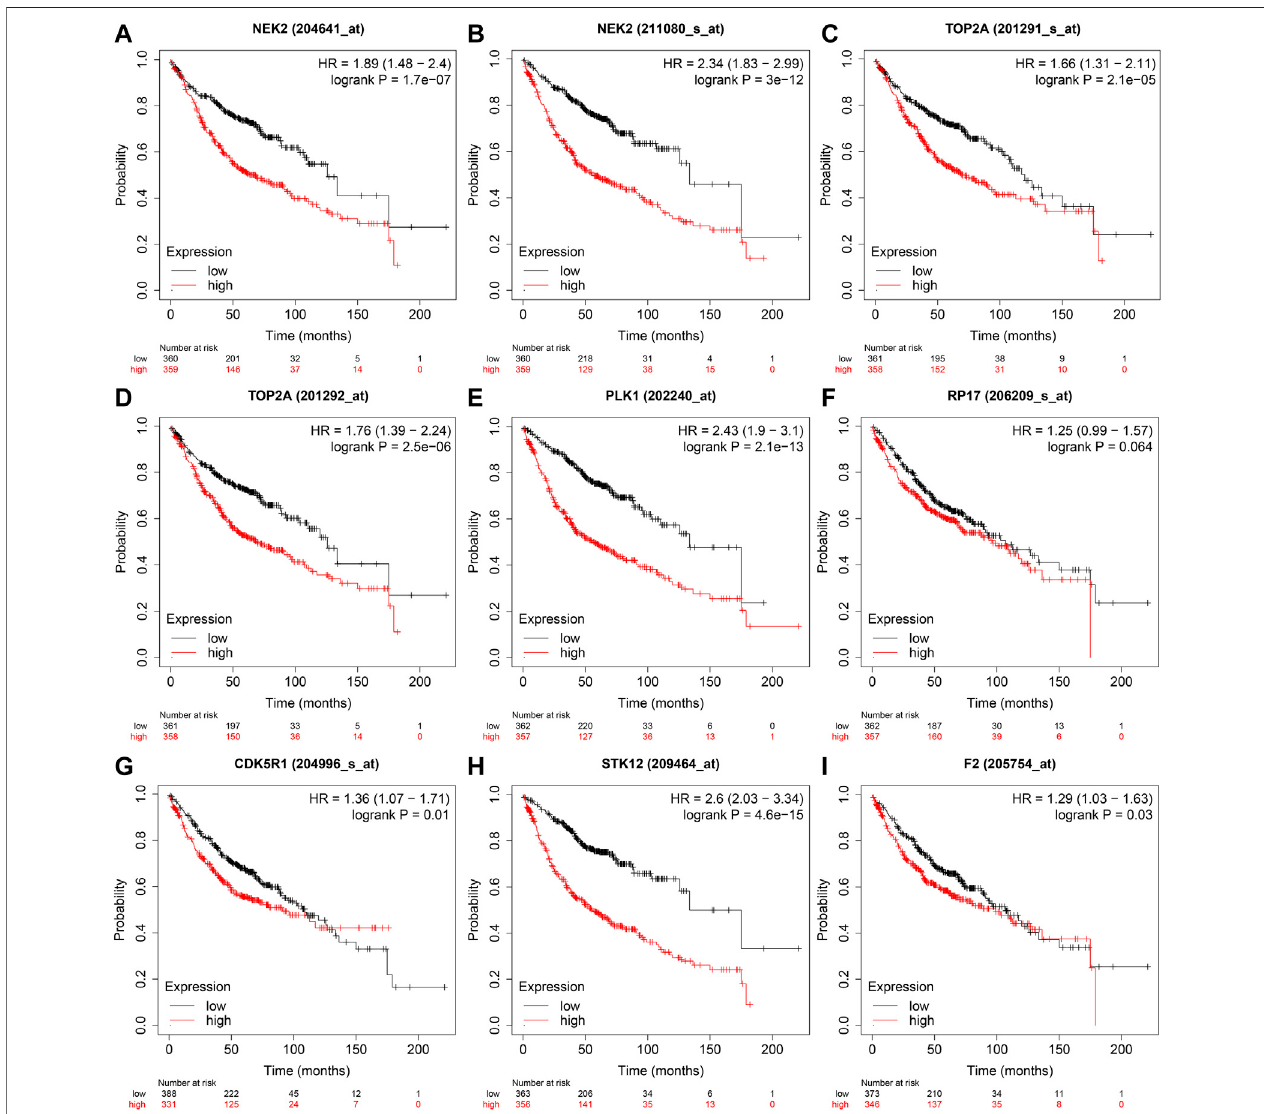
FIGURE 7 | The risk model factors were correlated with the OS of LUAD patients in the Kaplan-Meier Plotter database. Note: OS, overall survival; LUAD, lung adenocarcinoma.